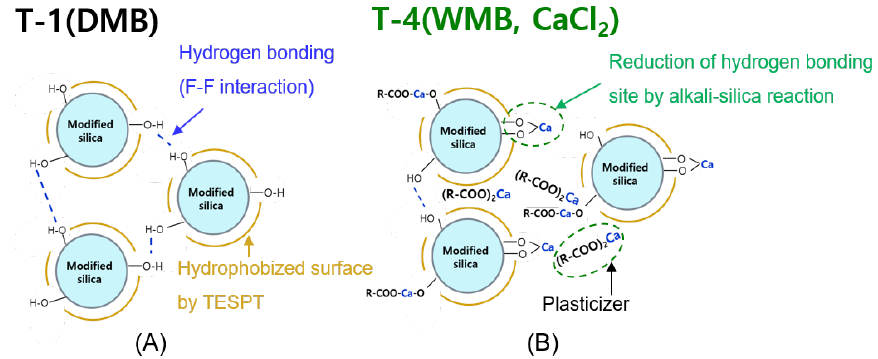
Figure 4. Illustration of expected filler network structure in the silica filled compounds: ( A ) the T-1 (DMB) compound, which has a residue silanol group and interaction between silica by hydrogen bonding and ( B ) The T-4 WMB compound using CaCl 2 , which has fewer silanol groups than the DMB compound by alkali-silica